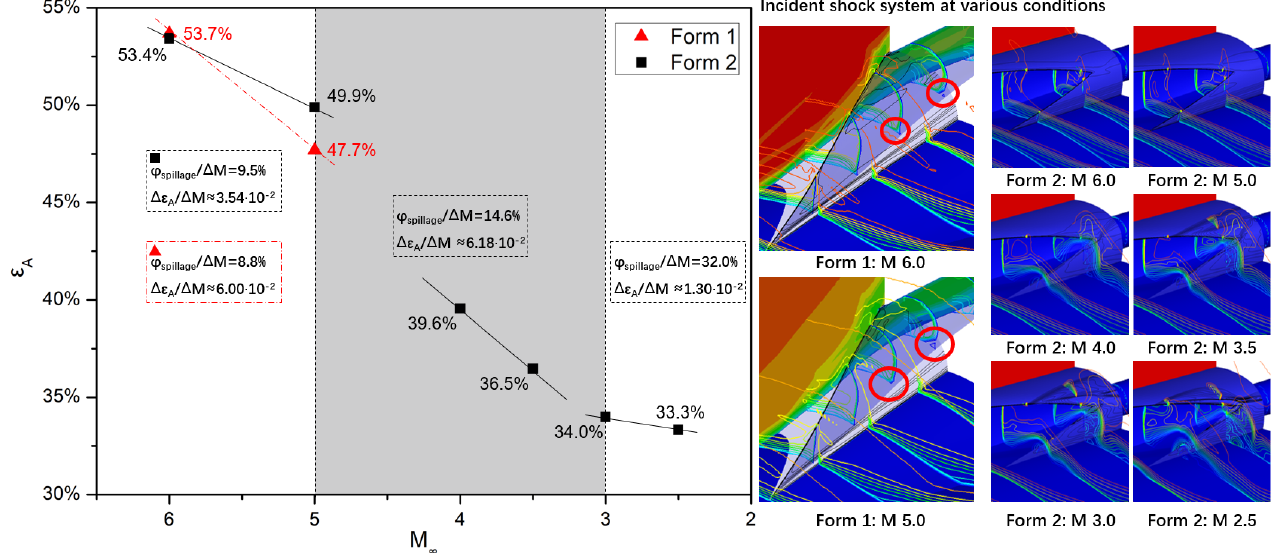
Figure 11. Impacts of M ∞ on the inlet distortion and flow spillage.